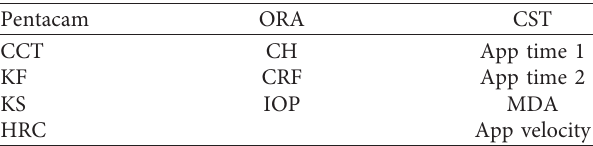
CCT: central corneal thickness, Kf: keratometry of flat meridian, Ks: keratometry of steep meridian, CH: corneal hysteresis, IOP: intraocular pressure, CRF: corneal resistance factor, App time 1: Applanation time 1, App time 2: Applanation time 2, MDA: maximum deformation amplitude, HRC: highest radius of